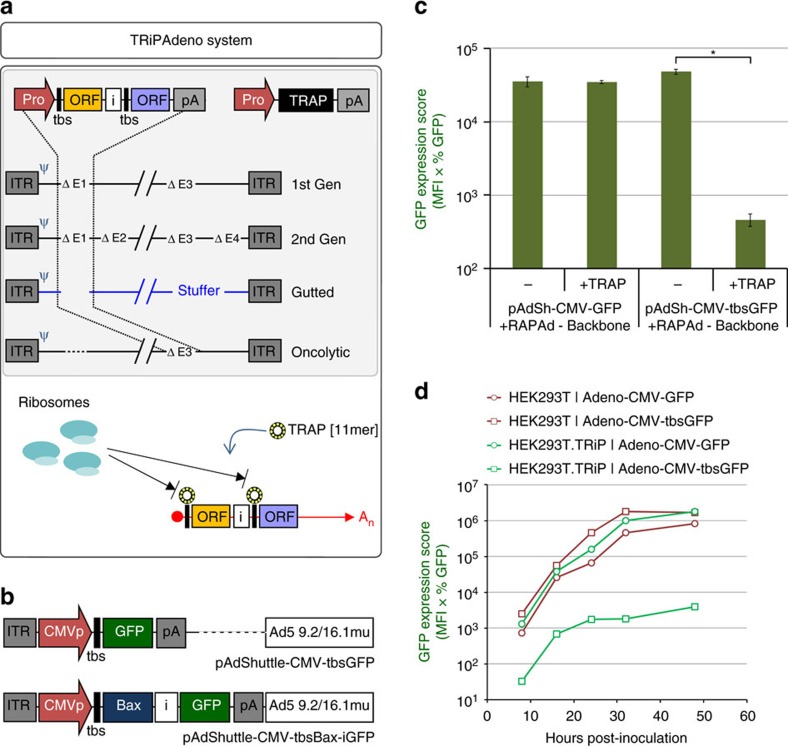
Repression of GFP during production of TRiPAdeno-GFP vectors.(a) The TRiPAdeno system, which requires: vector genome (with tbs-modified transgene(s)), helper functions and a TRAP expression cassette. TRiPAdeno is suited to the production of first/second generation Ad vectors, as well as Gutted (Helper-dependent) and Helper-independent Oncolytic Ad vectors. (b) The tbs-modified adenoviral type 5 shuttle plasmids used in the study, containing the ‘left' ITR, transgene cassette and adenovirus homology block of 9.2–16.1 map units. Bax was used to exemplify production of a vector expressing high-levels of a toxic gene (see text and Fig. 7). (c) Repression of GFP expression during vector recombination together with the pRAPAd back-bone plasmid in HEK293T cells. Data are mean average values±s.d. [log10-transformed data] (n=3); *P<6.7 × 10−5 [Welch's t-test]. (d) Vector stocks generated from (c) were used to transduce either HEK293T or HEK293T.TRiP cells at a multiplicity of infection (MOI) of 0.01, and replicate cultures analysed by flow cytometry at different points post-inoculation during one round of vector amplifcation phase to generate GFP Expression Scores. (Pro, promoter; ITR, inverted terminal repeat; Ψ, packaging signal; tbs, TRAP-binding sequence; ORF, open-reading frame; `i', internal ribosomal entry site (encephalomyocarditis virus); polyA, polyadenylation signal; An, poly-adenides).